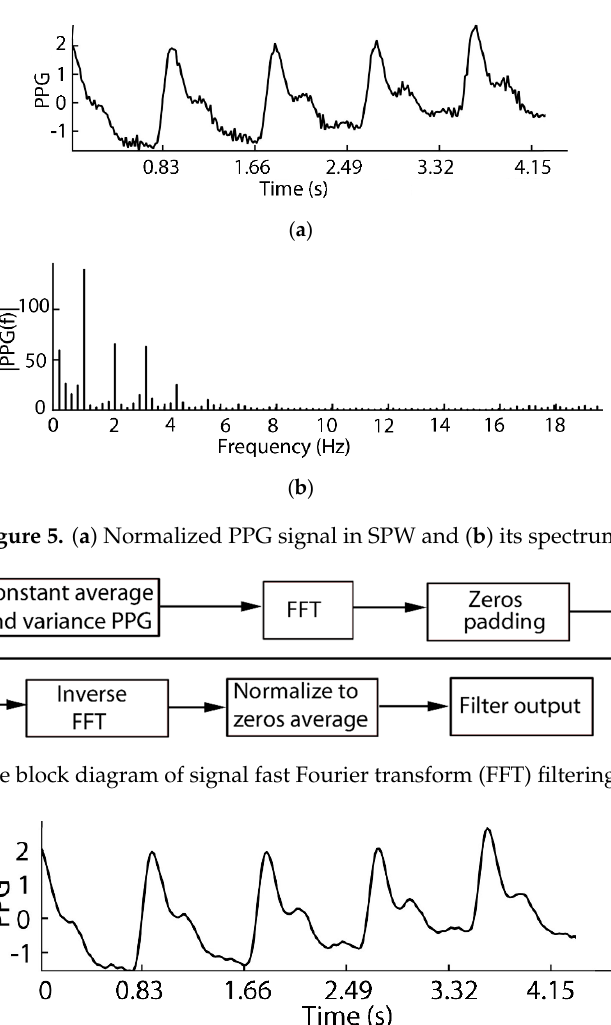
Figure 4. PPG with signal preprocessing window (SPW), blood pressure estimation window (BPEW) and peak detection window (PDW).